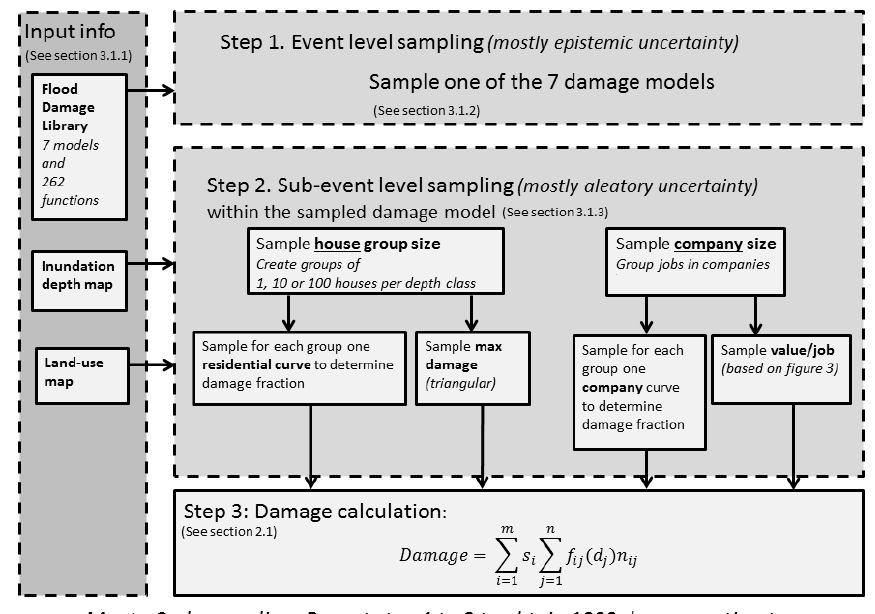
Figure 1. Overview of the different sample steps undertaken in the Monte Carlo